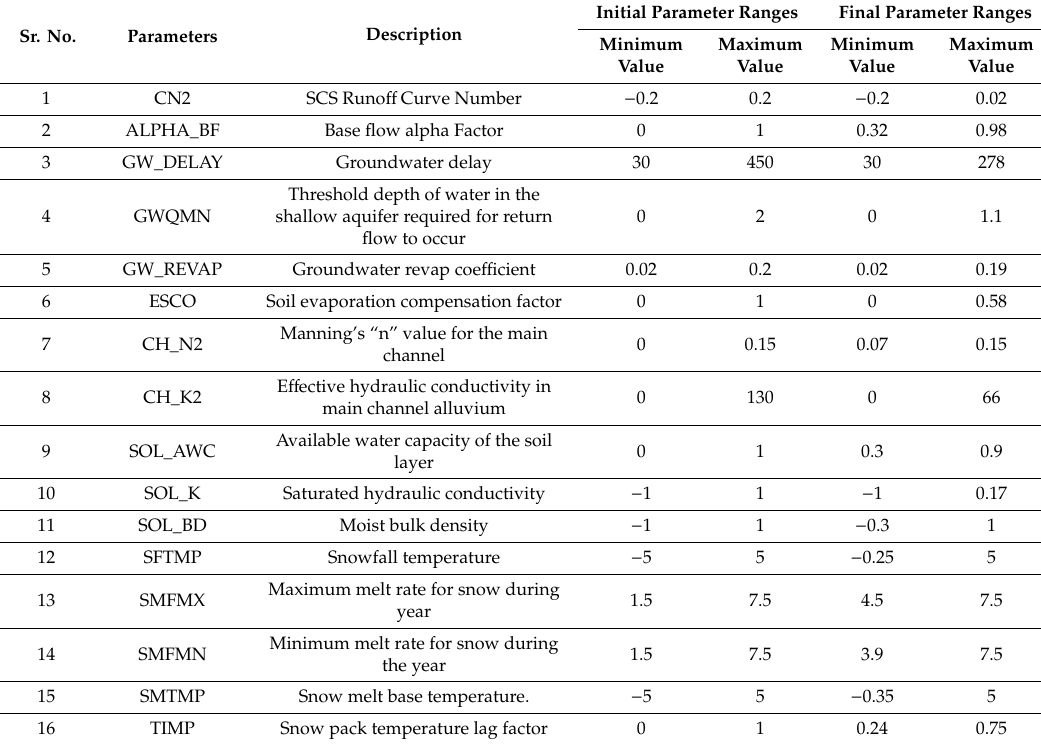
Table 5. Description of parameters with the initial and final parameter in SUFI-2. Sr.